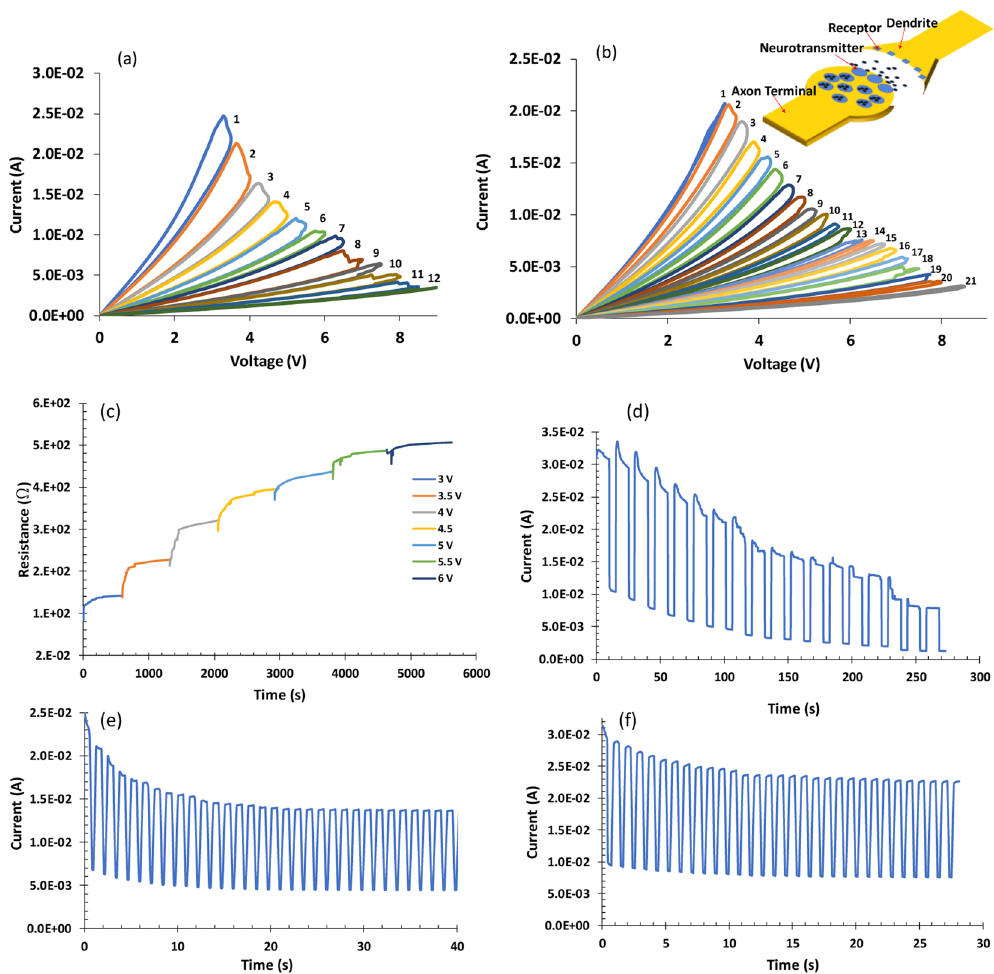
Figure 5. I-V traces and DC response of NeuroMem devices under the application of: ( a ) 12 voltage sweeps across fresh NeuroMem device, with a voltage step of 0.5 V. ( b ) 21 voltage sweeps across fresh NeuroMem device, with a voltage step of 0.25 V. ( c ) consecutive increasing writing voltage pulses from 3 V to 6 V with step of 0.5 V, gap of 50 µ m ( d ) consecutive increasing writing voltage pulses from 2.5 V to 5.9 V with step of 0.2 V and 1 V reading pulses, the width of the writing and reading pulses is 10 s and 1 s, respectively, device gap is 50 µ m ( e ) consecutive writing voltage pulses of 4 V and 1.5 V reading pulses, the width of the writing and reading pulses is 0.5 s and 0.2 s, respectively, device gap is 50 µ m ( f ) consecutive writing voltage pulses of 4 V and 1.5 V reading pulses, the width of the writing and reading pulses is 0.5 s and 0.2 s, respectively, device gap is 80 µ